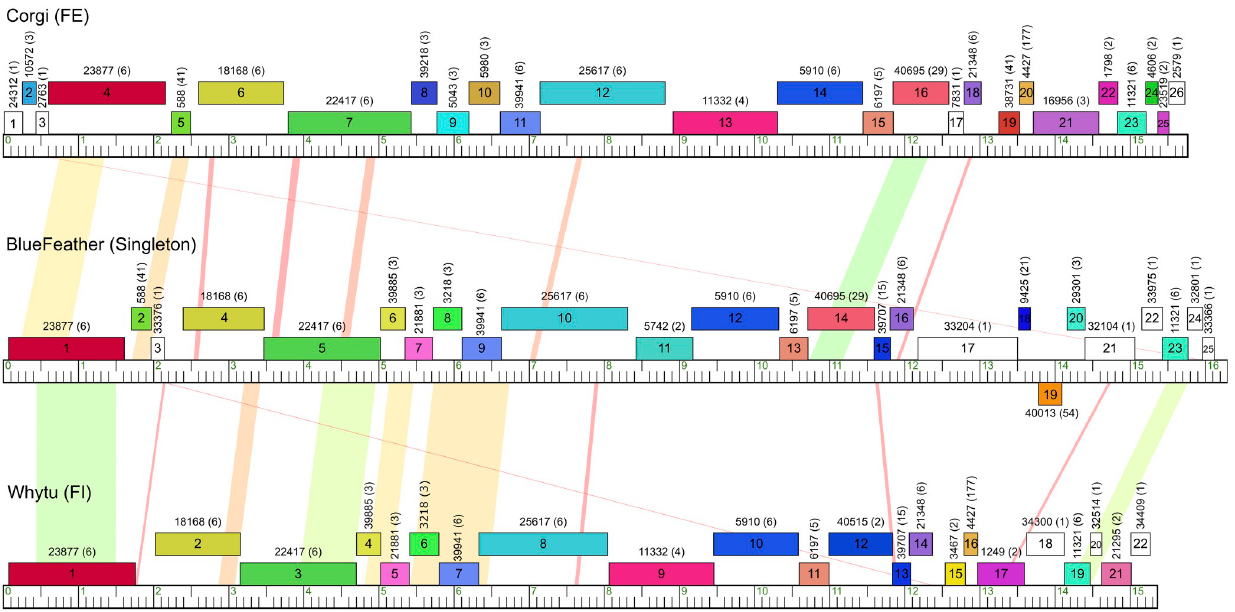
Fig 2. BlueFeather genome shares little nucleotide similarity but many phams with Cluster FE and former Cluster FI. The BlueFeather genome is linear with a relatively small length of 16 kbp. Of the 25 identified ORFs, 18 were of known function, 6 were orphams and 1 was a reverse gene. BlueFeather had little BLASTn homology to its most similar phages, as indicated by the limited orange and yellow shading.